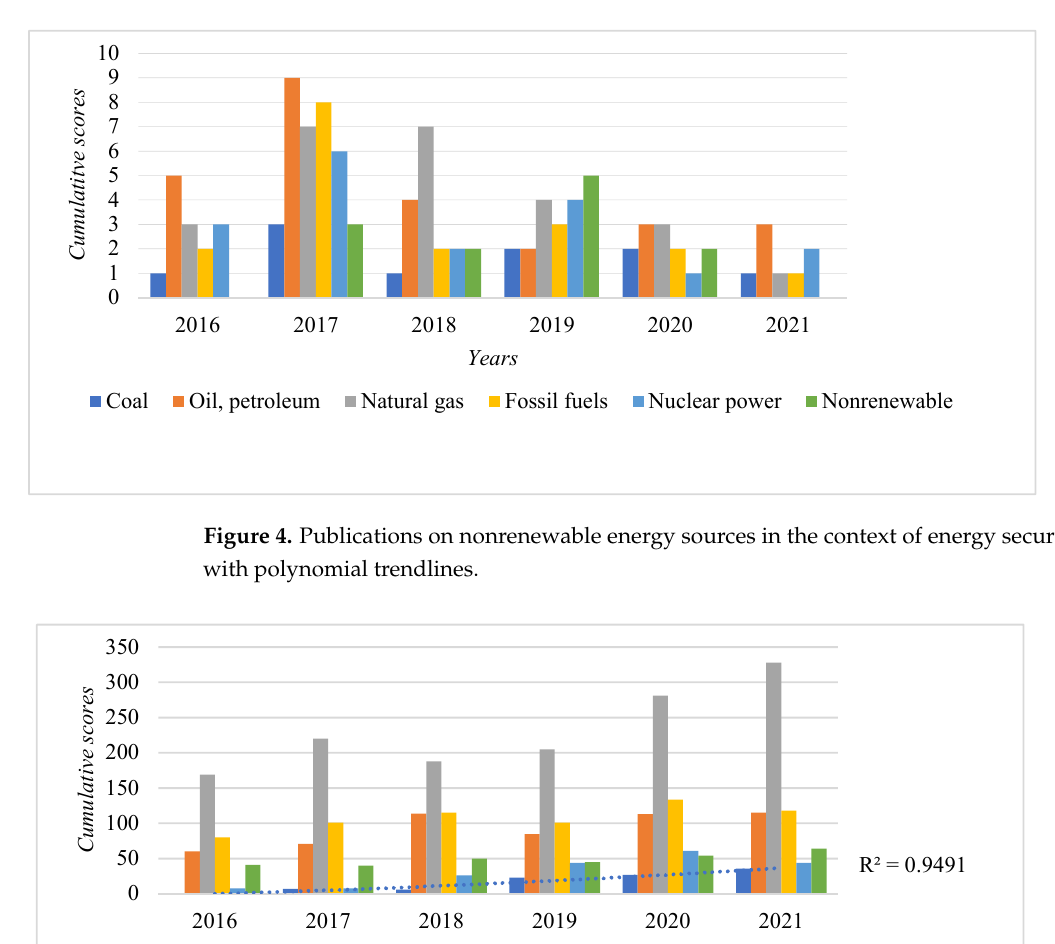
Figure 4. Publications on nonrenewable energy sources in the context of energy security education with polynomial trendlines.